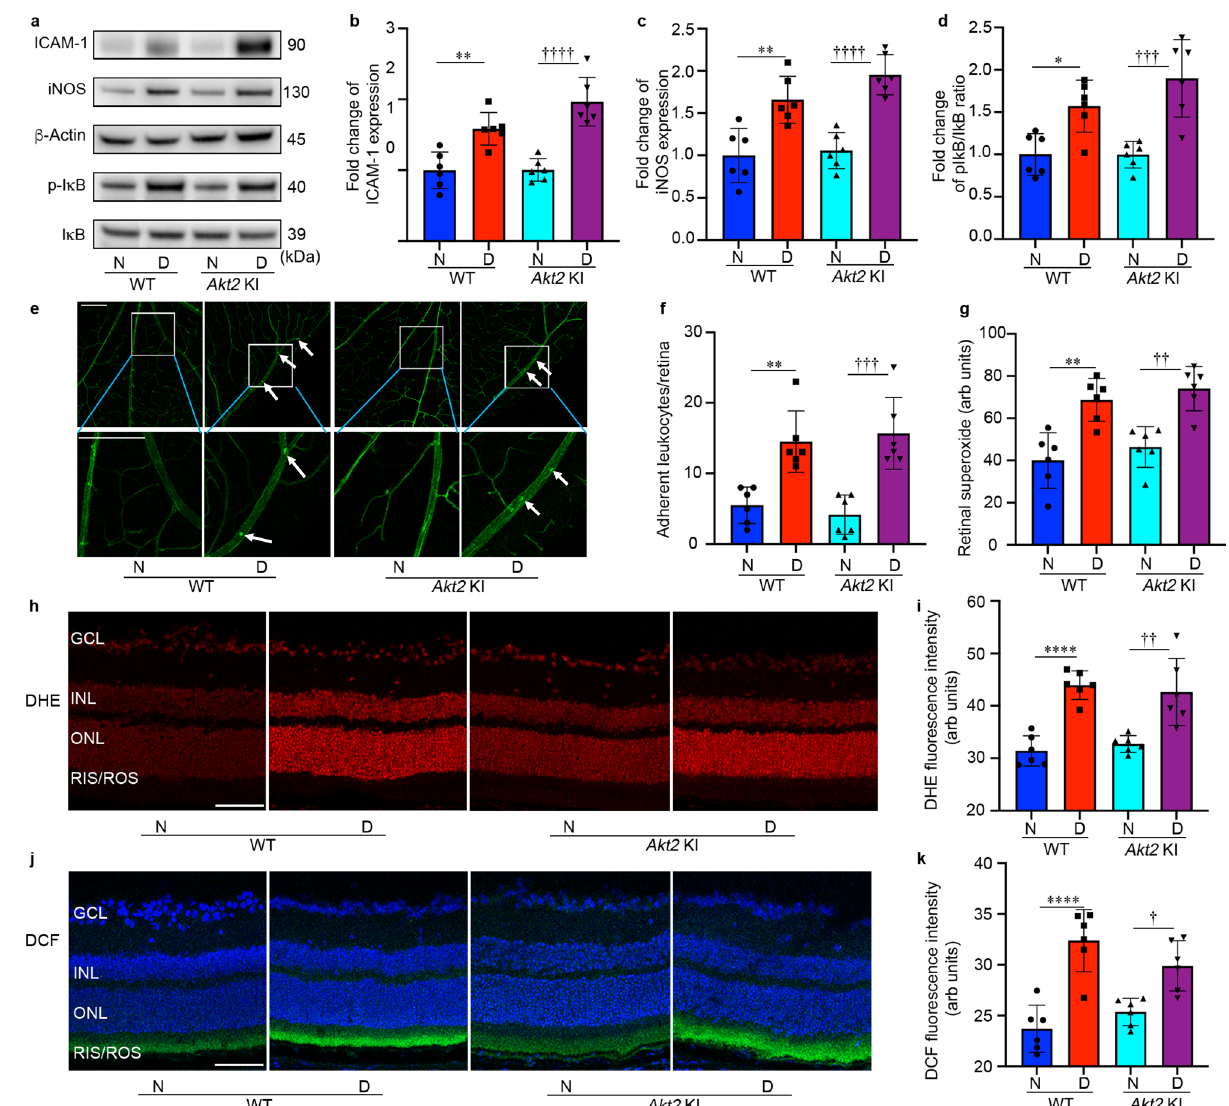
Fig.6|RPE-speci fi c Akt2 KIdoesnotin fl uencethediabetes-inducedincreasein pro-in fl ammatory protein level, leukostasis, or production ofreactive oxygen speciesinmiceafter 2 monthsofdiabetes.a Representative immunoblots and densitometry graphs showing that the diabetes-induced increase in the levels ofpro-in fl ammatorymarkers( b )ICAM-1,( c )iNOS,and( d )theratioofpI κ B/I κ B were not signi fi cantly decreased in Akt2 KI diabetic mice compared to WT diabetic mice. This result is in contrast to that found with Akt2 cKO mice ( e ) Representative images and ( f ) quanti fi cation of retinal leukostasis from each group. Arrows indicate leukocytes adherent to the retinal blood vessels. Dia- betes increased the number of adherent leukocytes in the retina of both WT and RPE-speci fi c Akt2 KI mice; Scale bar: 100 µ m. g Retinal superoxide was measured using the lucigenin method. Diabetes increased retinal superoxide production in both diabetic WTand Akt2 KI mice. h Representative images and ( i ) quanti fi cation of dihydroethidium (DHE)-stained (red) ROS. Scale bar: 100 µ m. Red fl uorescence intensity (DHE stain) was quanti fi ed at the INL and ONL together as they represent the majority of staining in the retina. Diabetes increased the production of retinal ROS in both WT and Akt2 KI mice. j Representative images and (k) quanti fi cation of dichloro fl uorescein (DCF) stained ROS. The DCF stain is localized primarily in the inner and outer